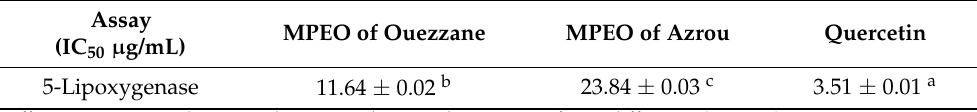
Table 6. In vitro